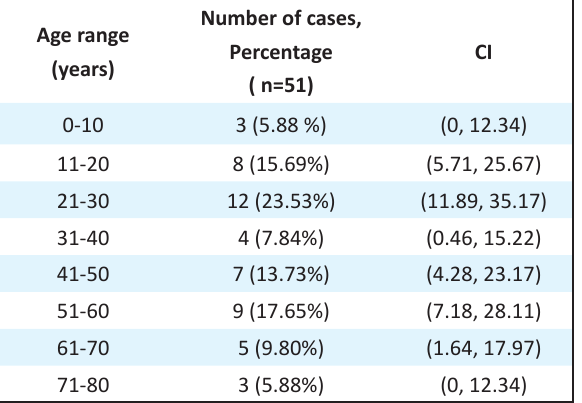
Table 1. Distribu ti on of cases according to age.